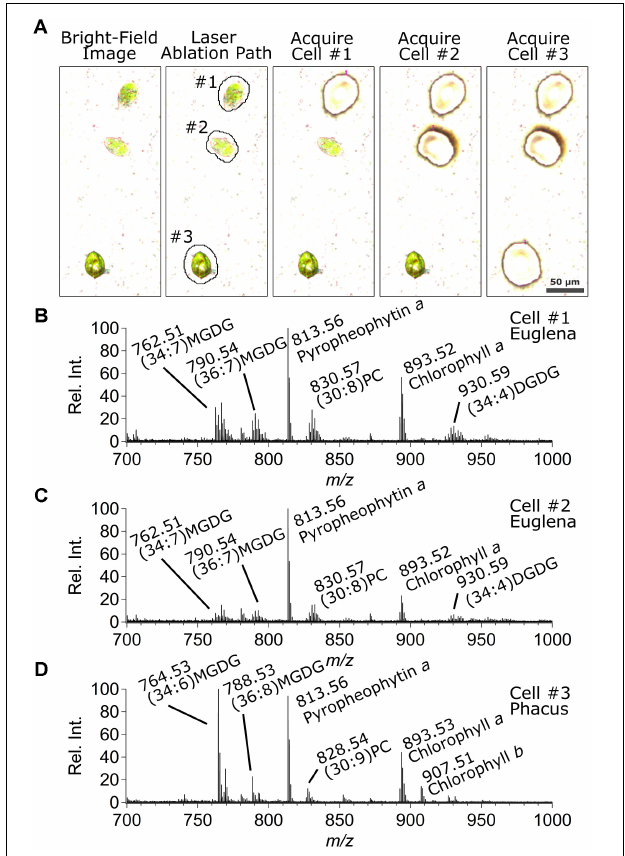
FIGURE 3 | (A) Bright-field optical images of the sampled Euglena gracilis ( top two cells, #1 and #2) and Phacus ( bottom cell, #3) algae cells ( column 1 ) before sampling, ( column 2 ) showing the laser cut path derived by the image analysis algorithm, and after sampling cells ( column 3 ) #1, ( column 4 ) #2, and ( column 5 ) #3. Positive ion mode ESI-MS TOF mass spectra corresponding to analyses of cells (B) #1, (C) #2, and (D) #3.